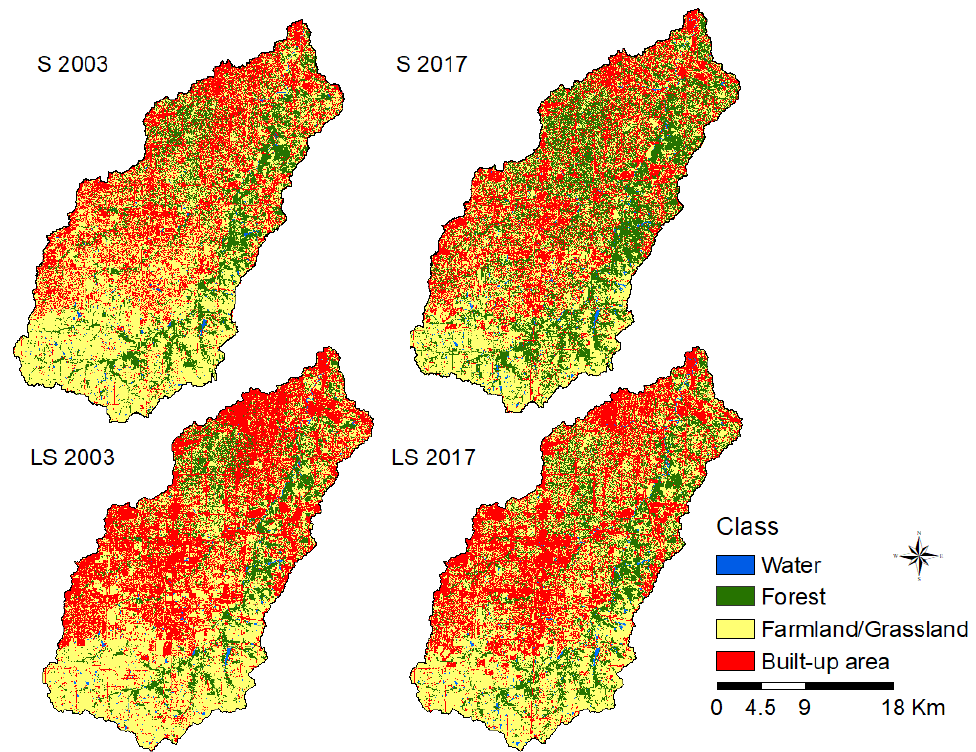
Figure 6. Classified images of SPOT (S) and LANDSAT (LS) (2003 and 2017).